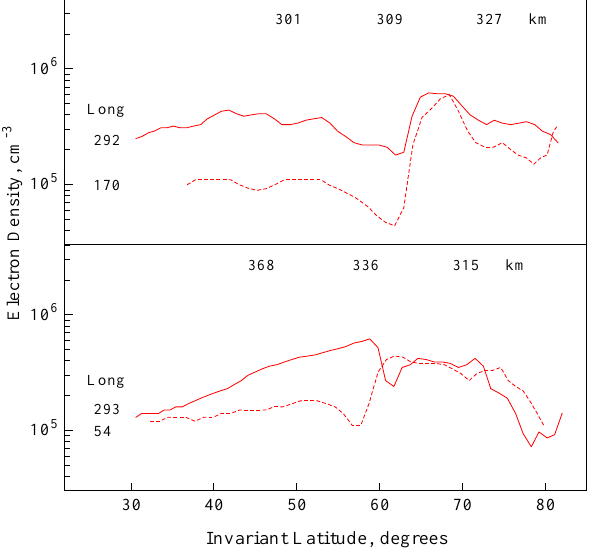
Fig. 12. Comparison of electron density profiles observed in differ- ent longitude sectors. In both cases, one profile was recorded near the longitude of the geomagnetic pole (solid red line), the other one about 120 ◦ apart (dashed red line). The format of data presenta- tion corresponds to that in Fig. 1, except that this time the geo- graphic longitudes, not the universal times, are indicated. The mea- surements presented in the upper panel were obtained on 23 Decem- ber 1981; they refer to about 06:00MLT and low levels of geomag- netic activity (Kp ≤ 2 + ) throughout the period of interest. Similar conditions apply to the data set collected on 14 December 1981, which is presented in the lower